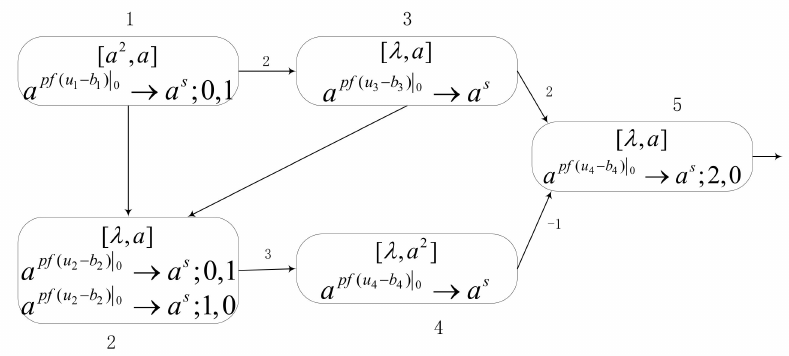
Figure 3. An example of the SNMC model. It is an explanation of the model workflow.